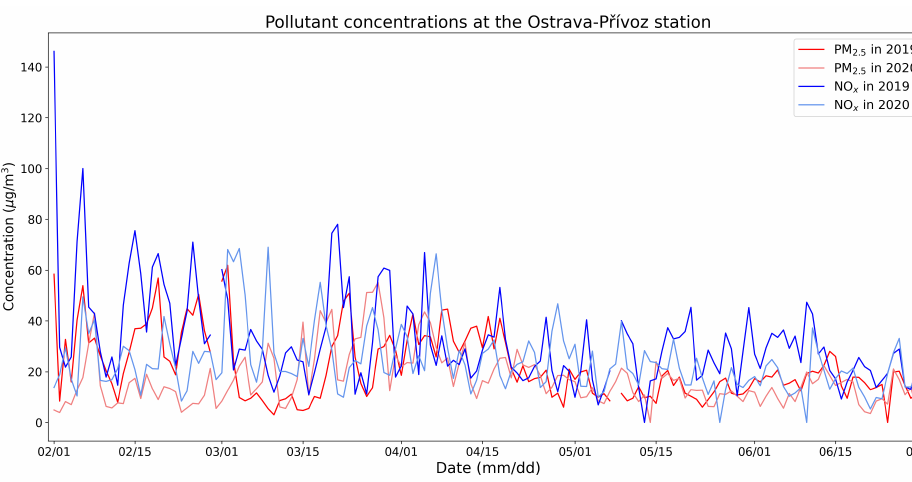
Figure A4. Daily average concentrations at the Ostrava-Pˇrívoz